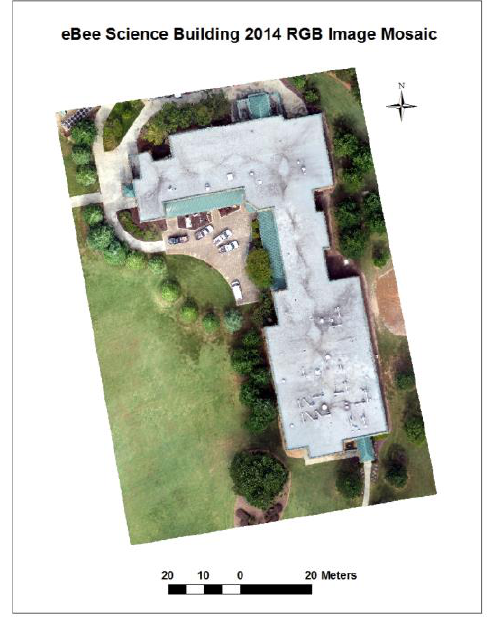
Figure 1. eBee Science Building Mosaic